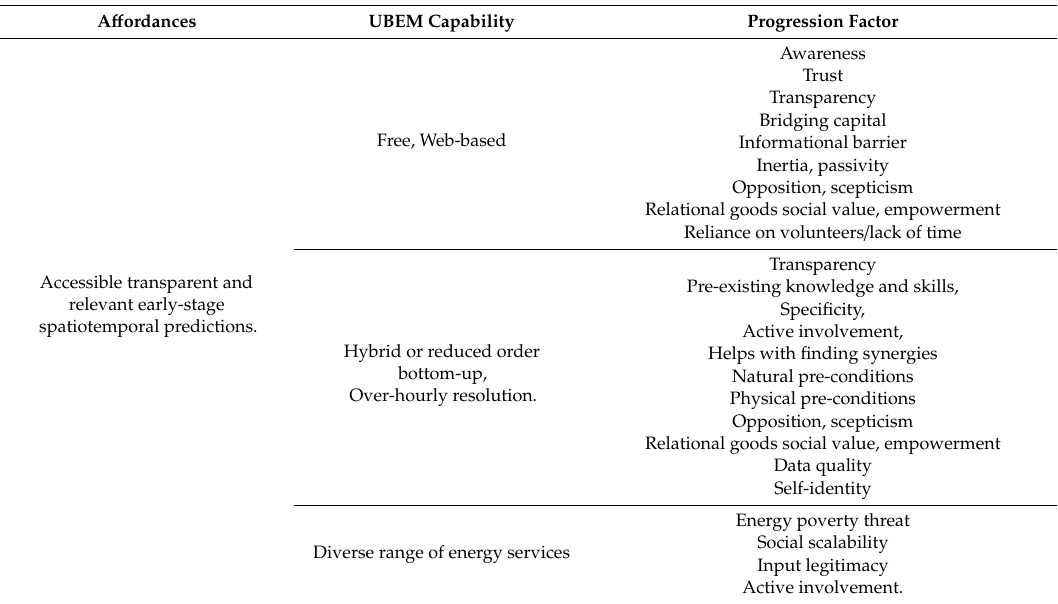
Table 10. Identified a ff ordances in relation to constituent capabilities and related goals (progression